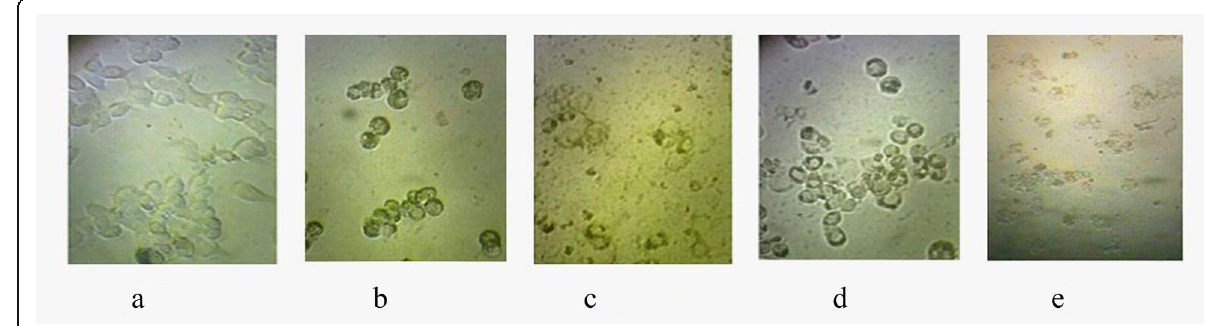
Fig. 5 Morphological changes of HepG2 cell line after 24 h treatment with various extracts and bioactive compounds obtained from S. platensis a control, b 1.8 mg/ml aqueous extract, c 1.3 mg/ml methanolic extract, d 0.7 mg/ml phenolic compounds, and e 0.5 mg/ml